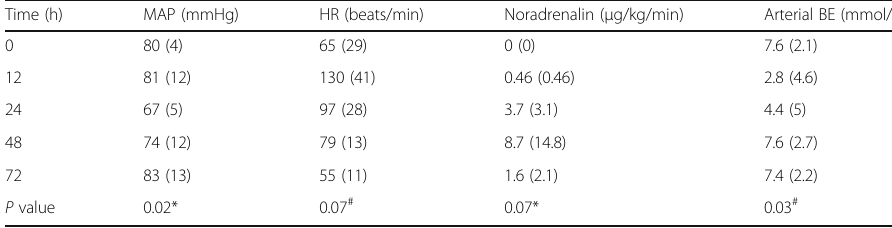
Table 1 Hemodynamic parameters of pigs with pneumosepsis